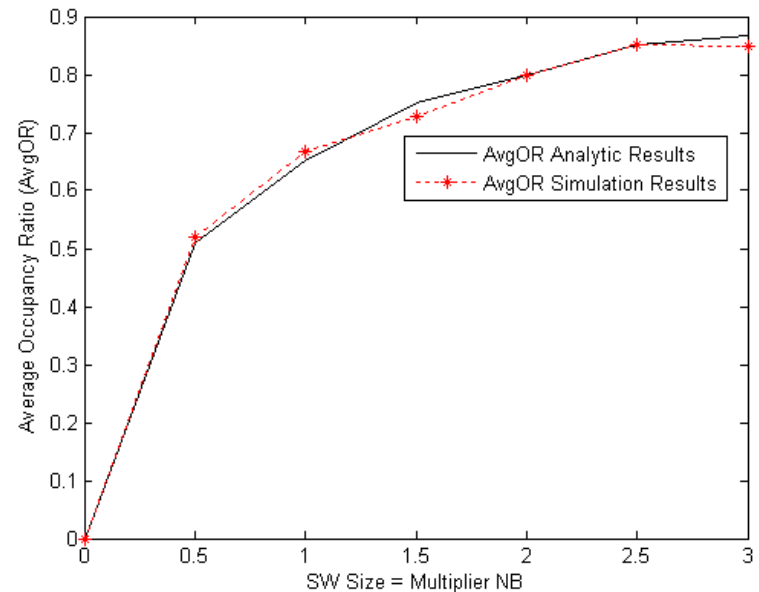
Figure 8. Impact of SW size on the average occupancy ratio.